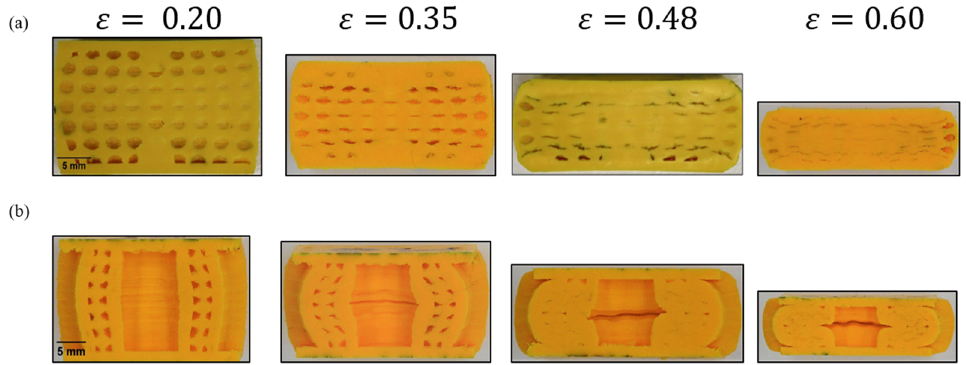
Figure 9. Deformation of the biomimetic specimen after cutting and grinding. ( a ) Compressive behaviour of the pores. ( b ) Compressive behaviour of the tubes.